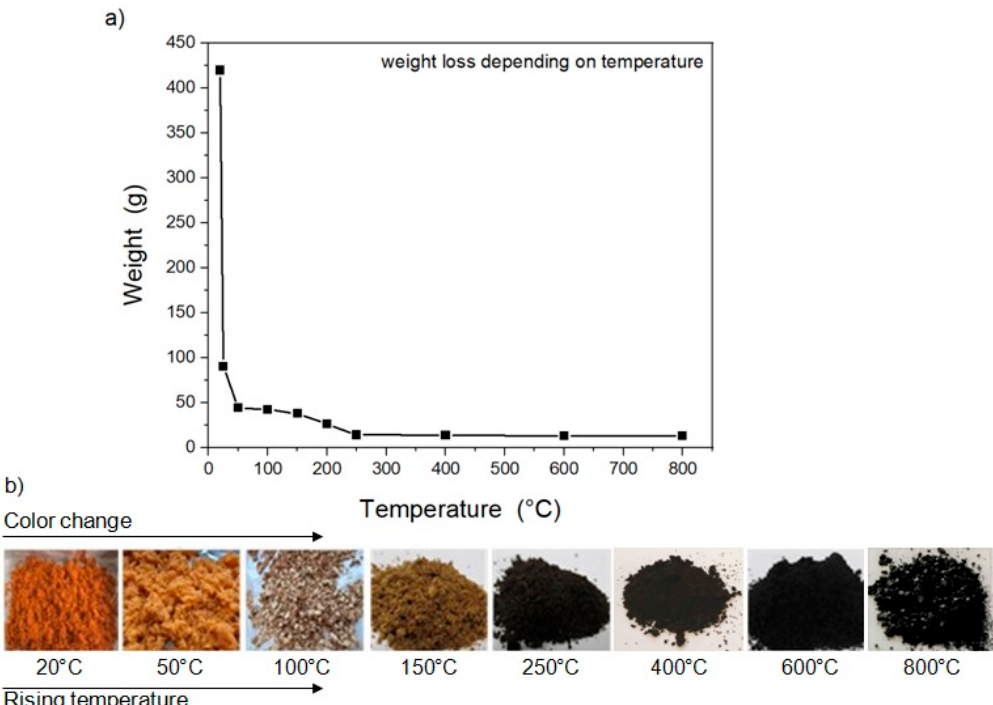
Figure 2. Effect of weight loss ( a ) and color change ( b ) during the stabilization and carbonization processes of the carrot pulp.